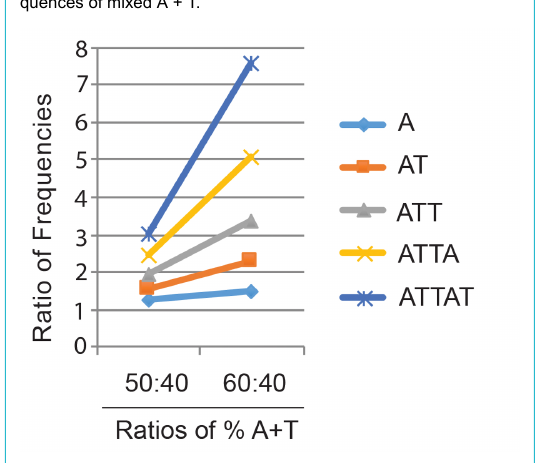
Figure 4: Small differences in base composition cause large differ- ences in AT motif frequency. Expected frequencies of A, AT etc. are compared between two levels of AT-richness. For example, compared with DNA of 40% AT, the sequence ATTA is 2.5 times more frequent in 50% AT DNA and 5 times more frequent in 60% AT DNA. The same approximate ratios would apply to other se- quences of mixed A + T.